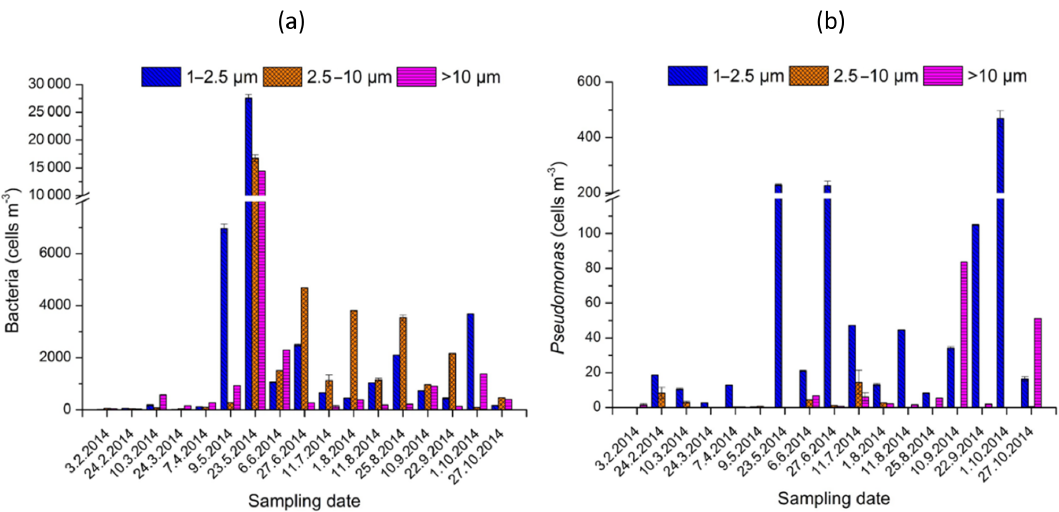
Figure 2. (a) The number of all bacterial cells over the sampling period, and (b) cells of bacteria belonging to genus Pseudomonas , detected with qPCR from the aerosol filters, specified by the particle size fractions.